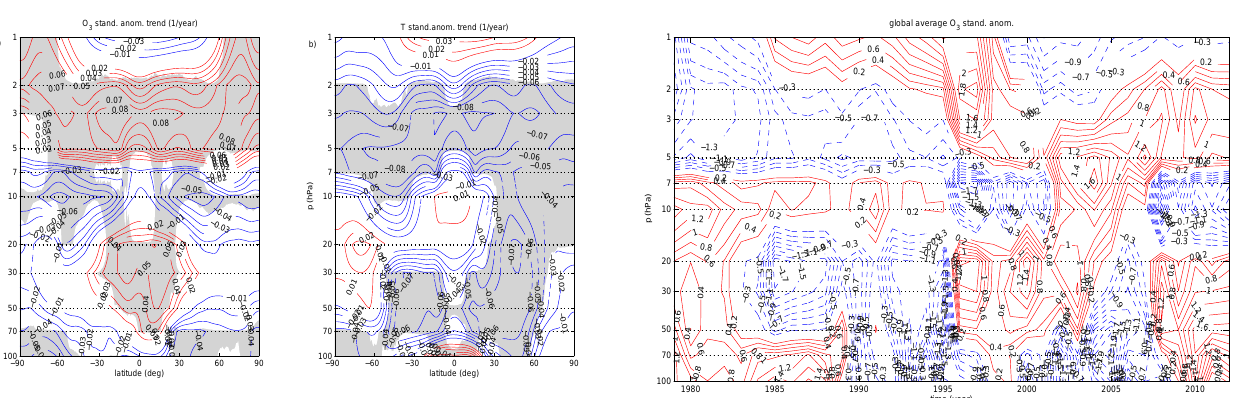
Figure 4. Time–pressure cross section of annual-mean, global- mean (area-weighted) standardized O 3 anomaly (solid red lines for positive values and dashed blue lines for negative ones; zero line is